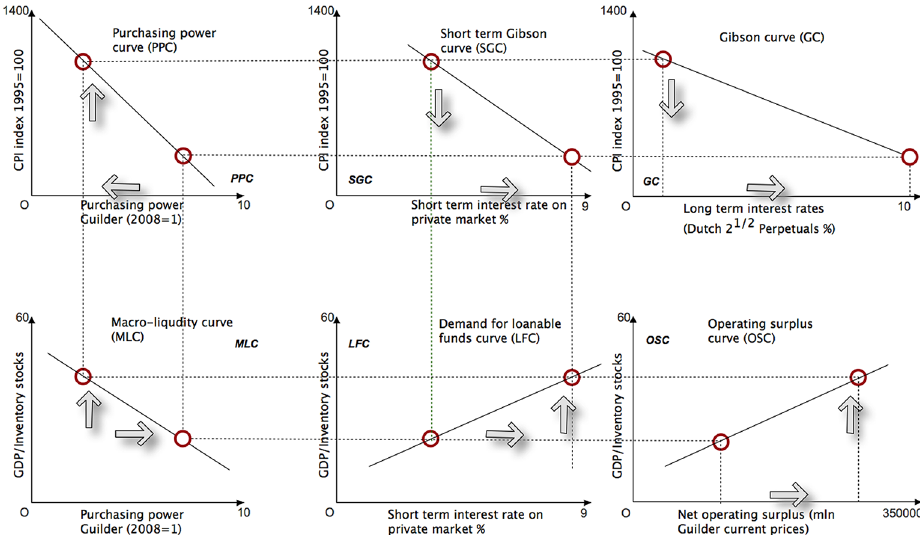
Fig. 4 . Gibson paradox curve model (the Netherlands 1950–2012) Source : authors’ calculation.